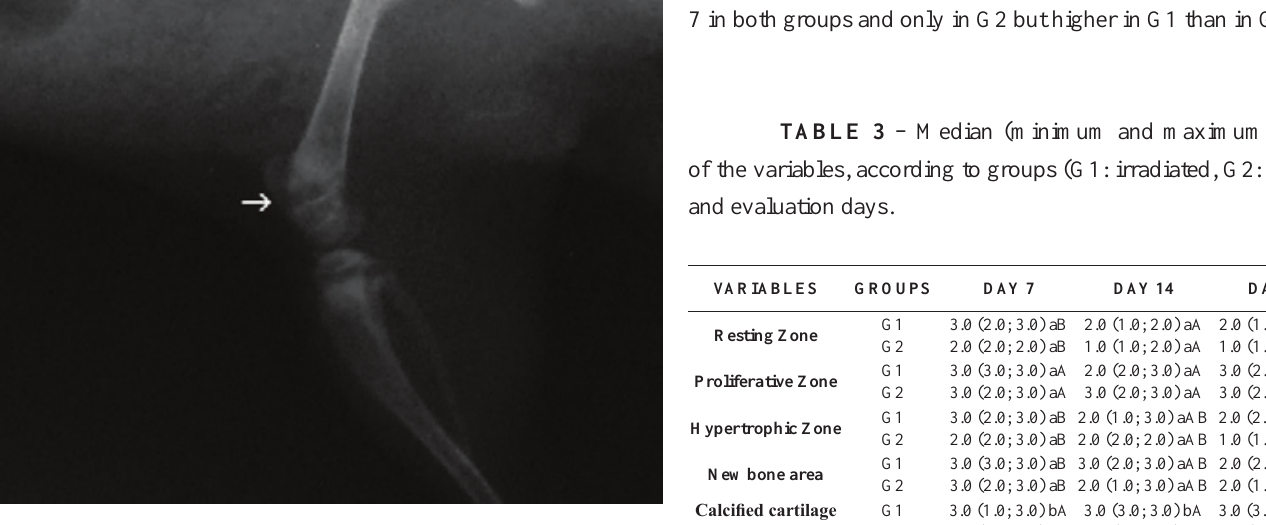
FIGURE 4 – Observe the presence of distal growth plate in a rat femur after 21 days of laser irradiation (arrow) in lateral radiographic view. TABLE 2 – Median (minimum and maximum) values of percent variation in right femur longitudinal length in relation to the basal value, by groups (G1: irradiated, G2: control) and evaluation days.